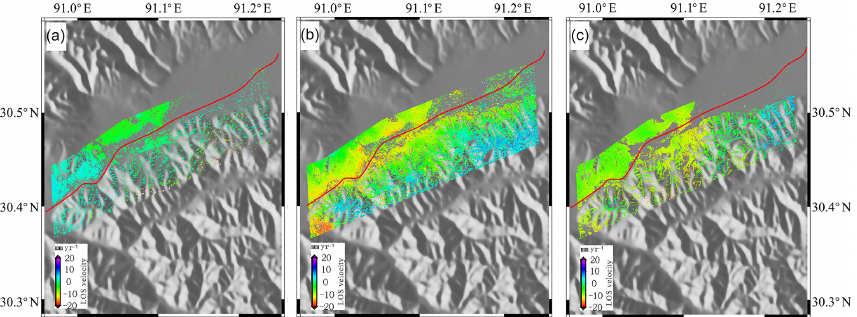
Figure 7. The deformation maps of the railway sequence changes from 2003 to 2010 in the Damxung section. (a) 2003–2005; (b) 2007; (c)